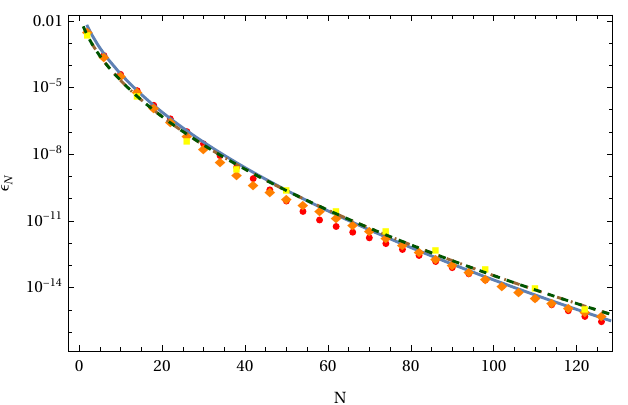
(cid:16) (cid:17) 1/2 − k for the three ML functions E α , E α , β , 2 N